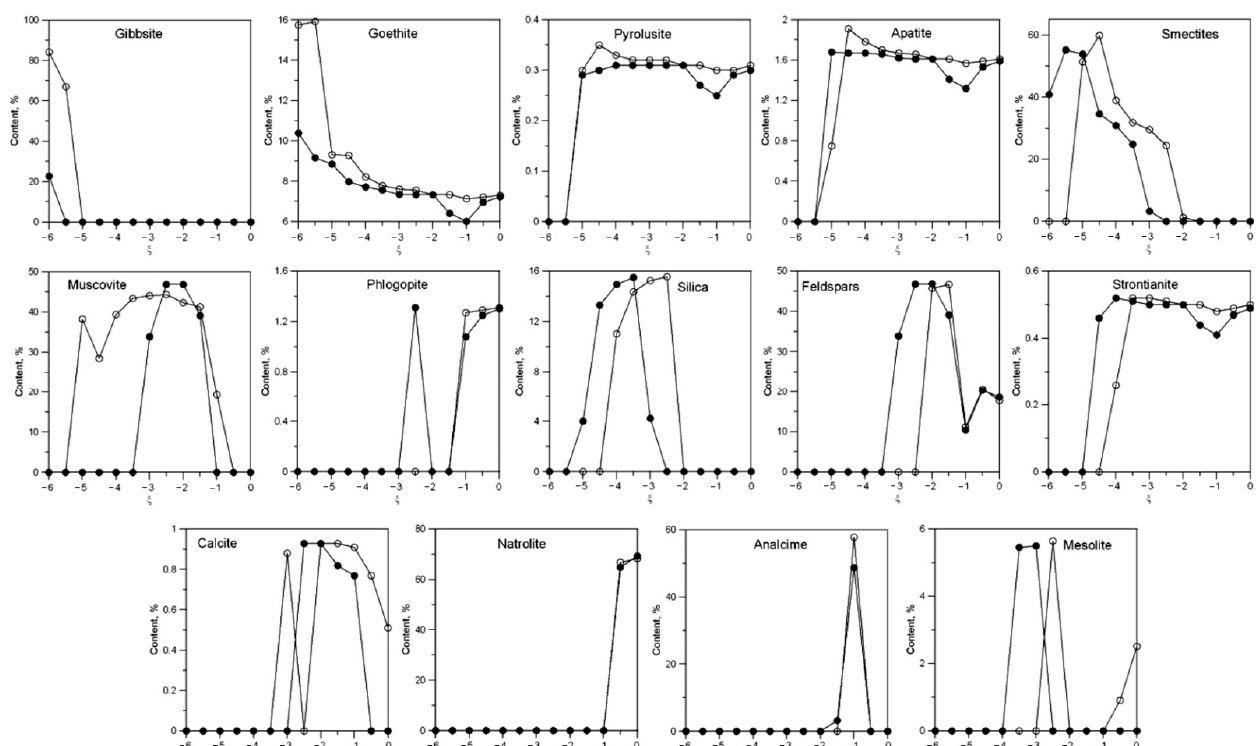
Figure 8. Content of newly formed mineral phases depending on the degree of interaction ξ and the amount of water in the system: 0.05 (white) and 0.01 (black).